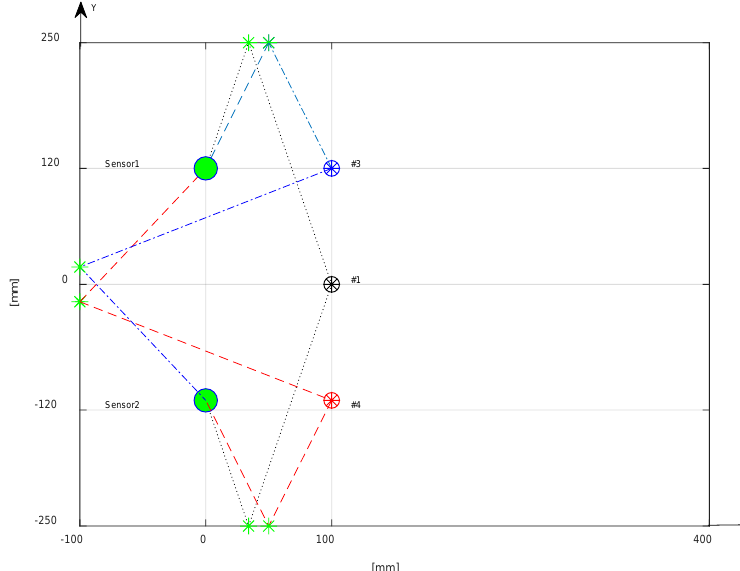
Figure 7. Calculated minimum edge reflection path for impacts #1, #3, #4, with respect to Sensor 1 and Sensor